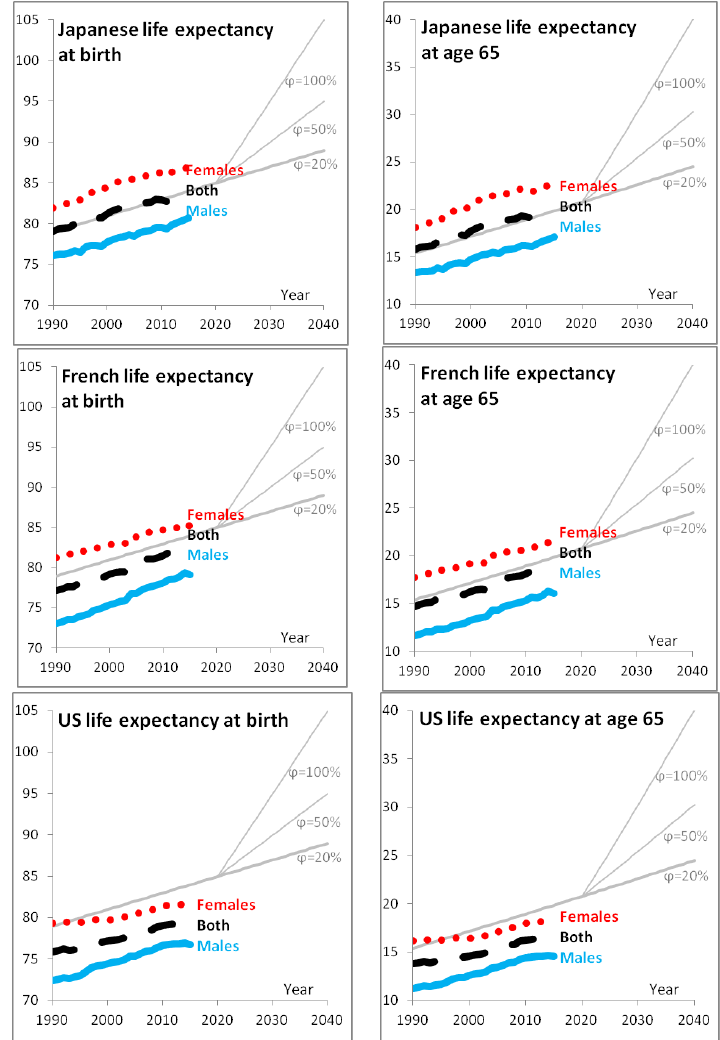
Figure A2. Static life expectancy at birth and at age 65, for three countries and as modeled. Life expectancy at birth (graphs on the left) and at age 65 (graphs on the right) are shown as function of calendar year, for Japan, France and the USA (graphs from top to bottom). Each graph shows the mortality of males in a (blue) continuous line, the mortality of females in (red) dots, the mortality of both in (black) dashes and the mortality of the model used in this article in portions of gray straight lines. More precisely, ϕ = 20% is used for the thick straight line and ϕ = 50% and ϕ = 100% is used for the two thin straight lines that start in